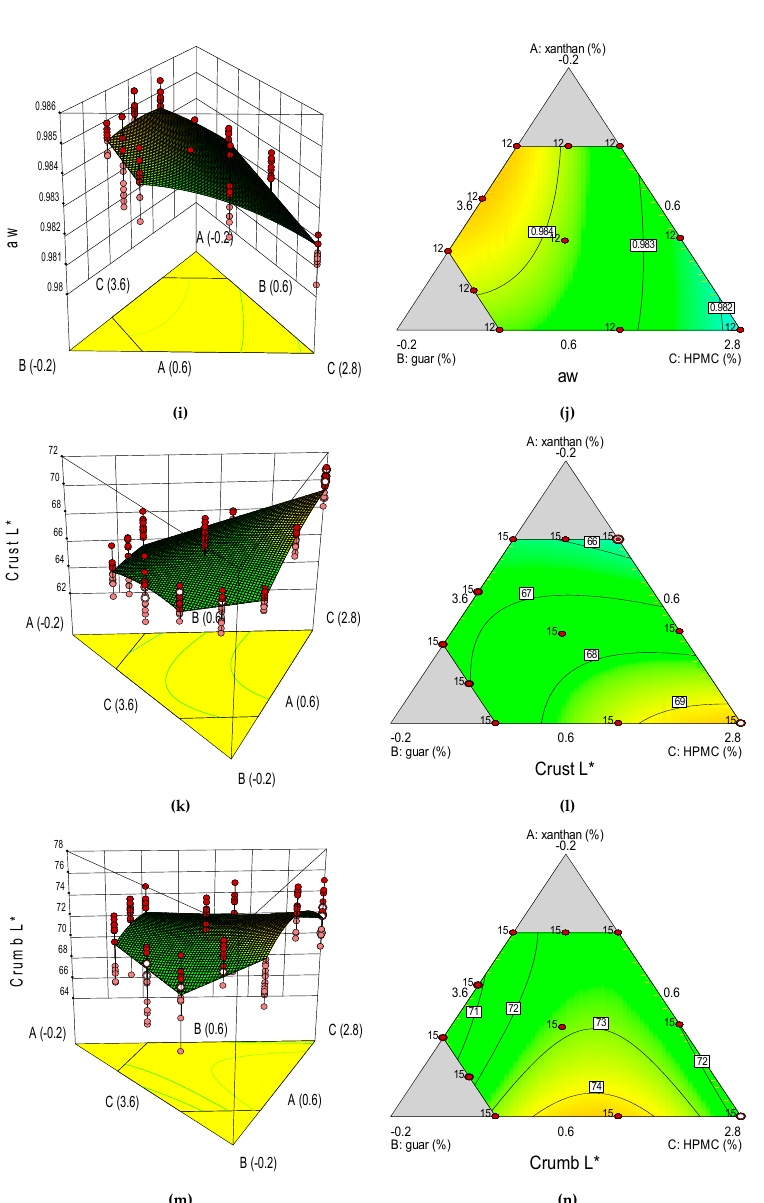
Figure 1. Three-dimensional surface (3-D, left) and two-dimensional contour (2-D, right) plots showing the effect of xanthan gum ( A ), guar gum ( B ), and HPMC ( C ) on GF batter and bread physicochemical properties, were: ( a ), stickiness 3-D; ( b ), stickiness 2-D; ( c ), firmness 3-D; ( d ), firmness 2-D; ( e ),